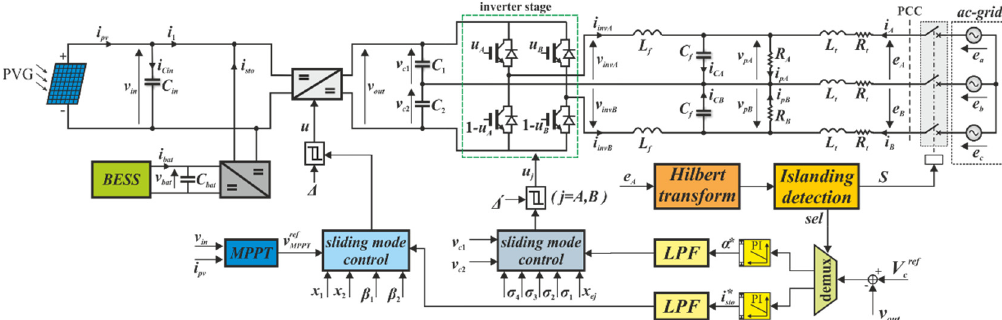
Figure 2. Overall system configuration.